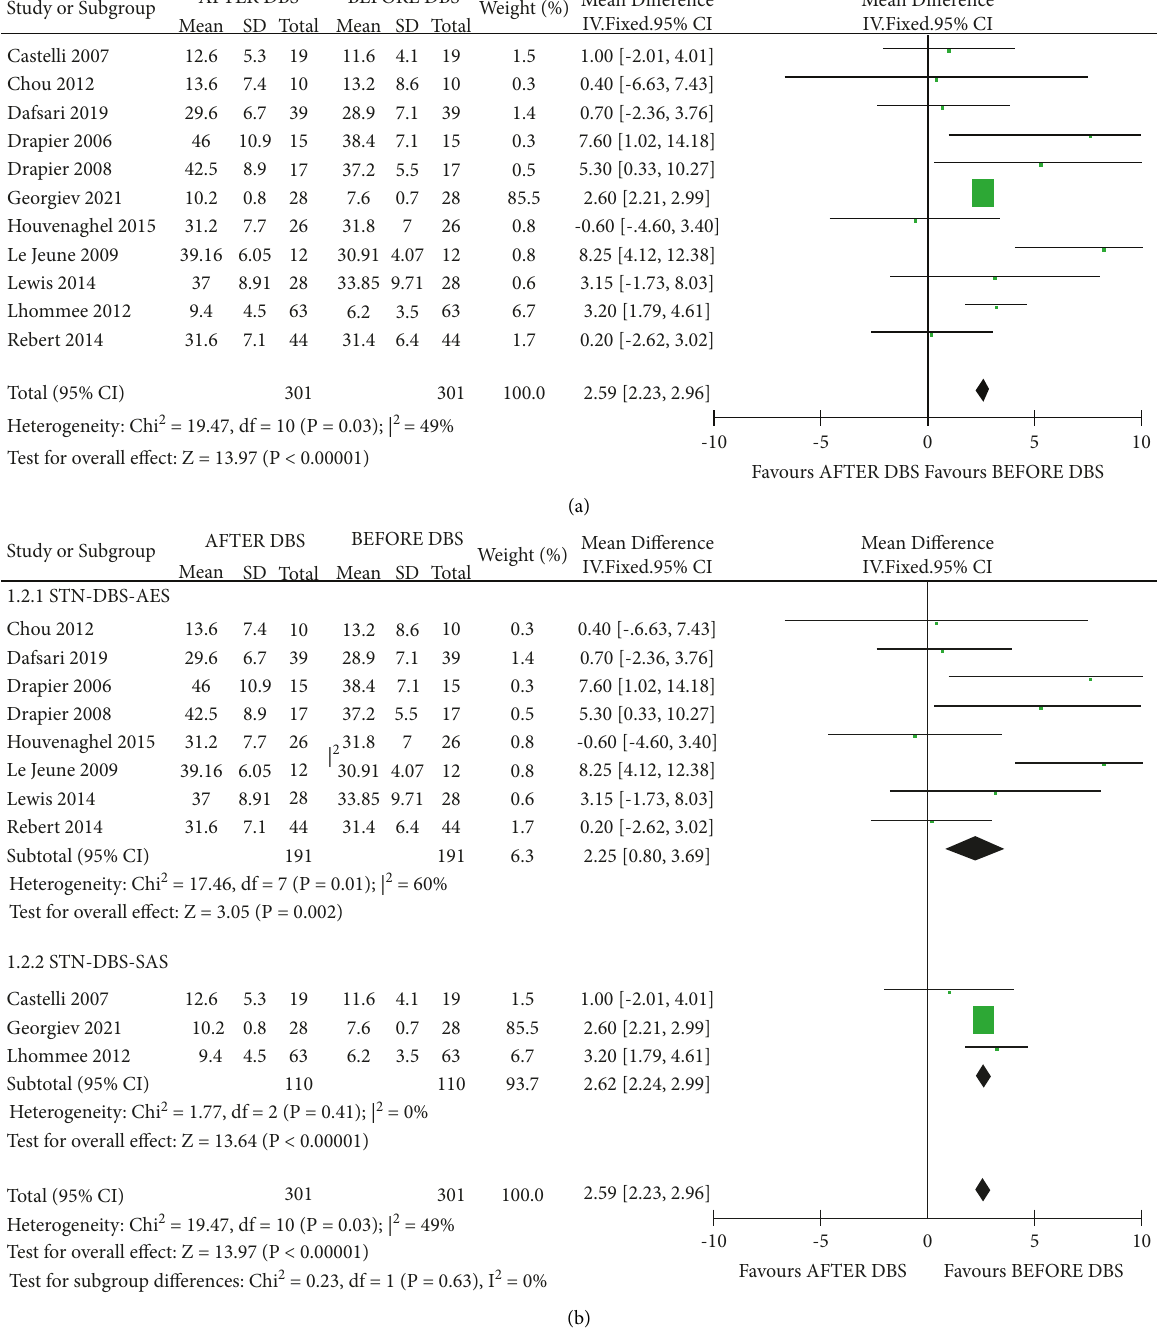
Heterogeneity: Chi 2 = 19.47, df = 10 (P = 0.03); | 2 =